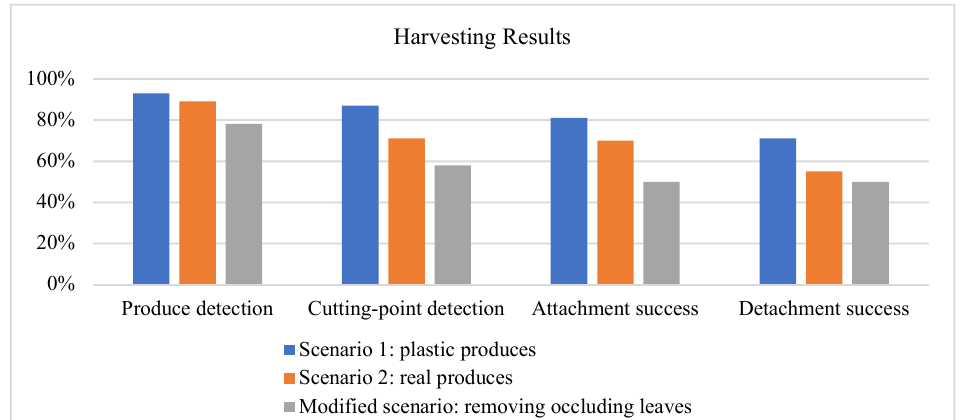
Figure 12. Harvesting rates for autonomous harvesting experiment.